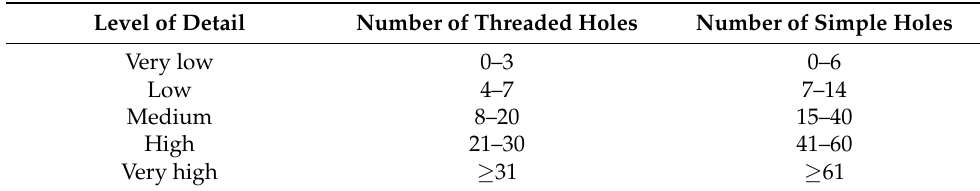
Table 6. Number of operations for each level of detail, considered for the definition of part complex- ity level.